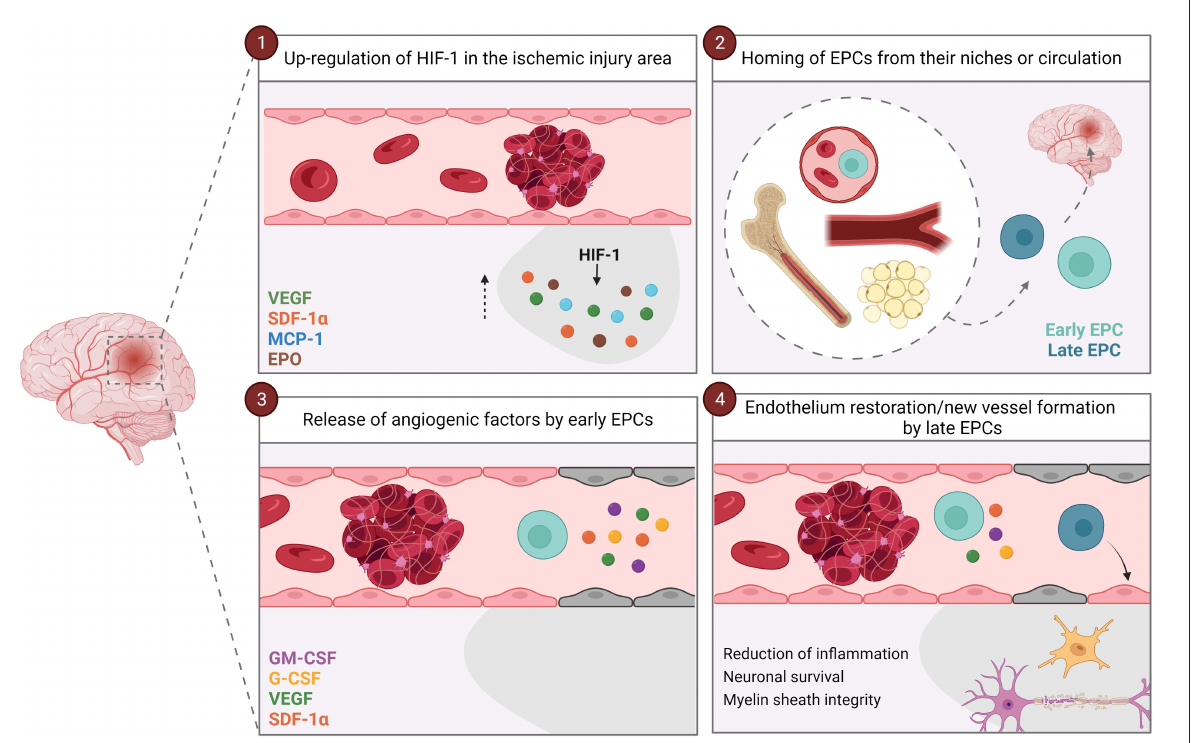
FIGURE1 Vascular repair mediated by EPCs. After an ischemic stroke, HIF-1 is up-regulated and induces the expression of VEGF, SDF-1 α , MCP-1 and EPO in the ischemic injury area (1) . These factors induce the homing of EPCs from their niches (bone marrow, vascular niches or white adipose tissue) or circulation to the ischemic brain area (2) . Firstly, early EPCs arrives at the site of injury, and paracrinally release factors that promote angiogenesis and recruit late EPCs (3) . Once the late EPCs arrive at the ischemic lesion zone, they restore the endothelium or from new vessels guided by the early EPCs (4) . In addition, both early and late EPCs reduce inflammation and promote neuronal survival and myelin sheath integrity. EPCs, endothelial progenitor cells; EPO, erythropoietin; G-CSF, granulocyte-colony stimulating factor; GM-CSF, granulocyte macrophage-colony stimulating factor; HIF-1, hypoxia-inducible factor-1; MCP-1, monocyte chemoattractant protein-1; SDF-1 α , stromal-derived factor-1 α ; VEGF, vascular endothelial growth